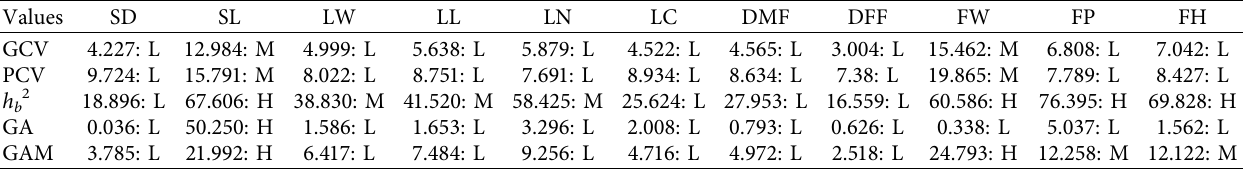
Table 2: Genotypic and phenotypic coefficient of variations, broad-sense heritability, genetic advance, and genetic advance as percentage of mean among agronomic and fruit characteristics of melons.